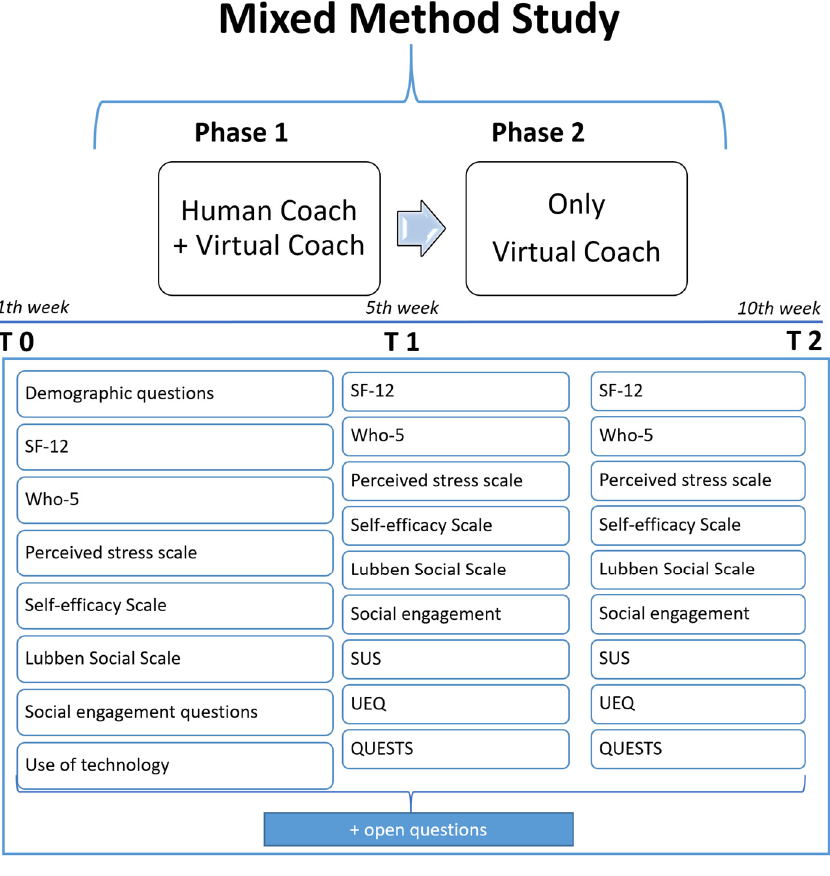
Figure 4. Study design.